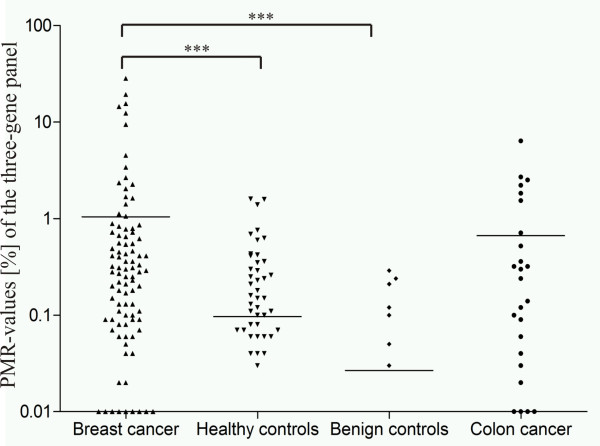
The biomarker panel including ITIH5, DKK3, and RASSF1A enables significant discrimination of breast cancer sera from various control conditions. Scatterplot illustrating the mean PMR values of the three-gene panel in the independent validation set. Combination of DKK3 and ITIH5 with RASSF1A increased the sensitivity to 67% (92 of 138) with a specificity of 69% (93 of 135) and 82% (32 of 39) in healthy and benign disease controls, respectively. ***P < 0.0001.